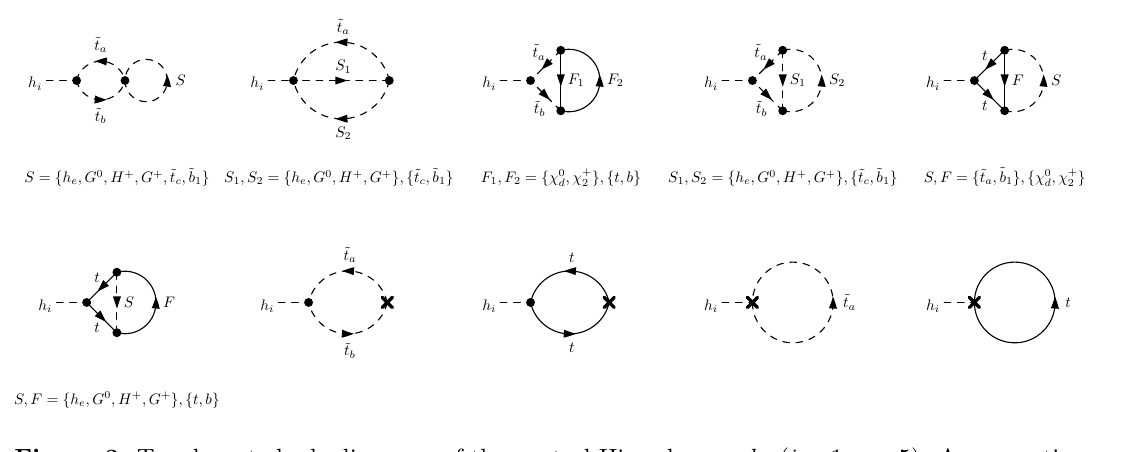
Figure 3 . Two-loop tadpole diagrams of the neutral Higgs bosons h i ( i = 1 ; : : : ; 5). A summation over all internal particles with indices a; b; c = 1 ; 2, d = 3 ; 4 ; 5 and e = 1 ; : : : ; 5 is